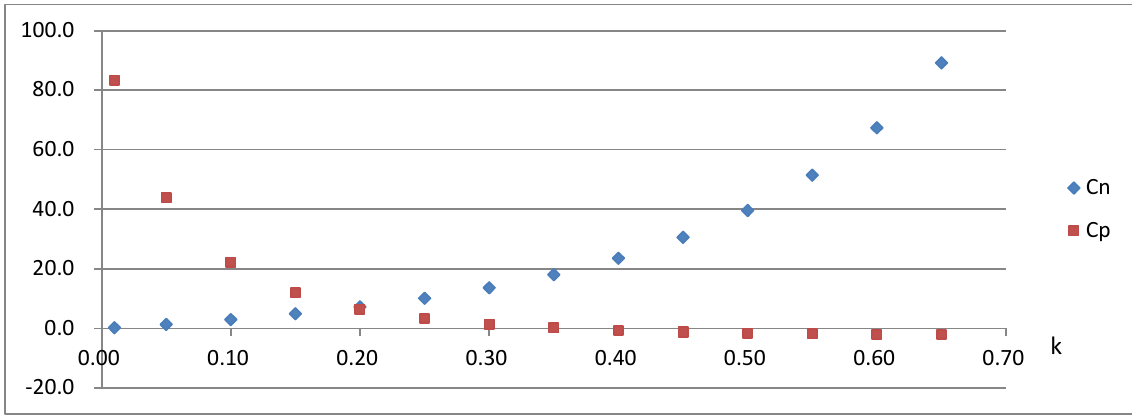
Fig. 2. Cp and Cn values corresponding to k ∈ [0.01,